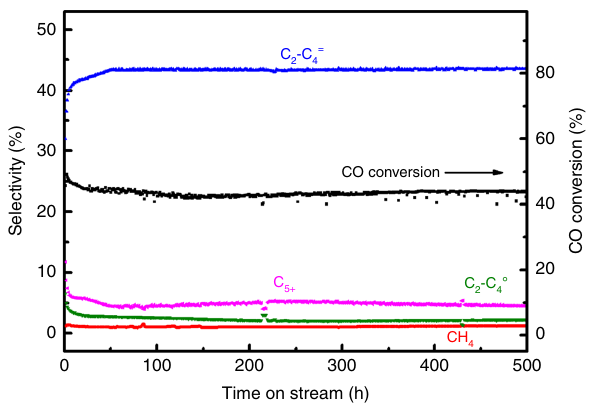
Fig. 7 Stability of catalyst. Time-on-stream of CO conversion and selectivity for ZnCr/low-Si AlPO-18 bifunctional catalyst. Reaction conditions: 390